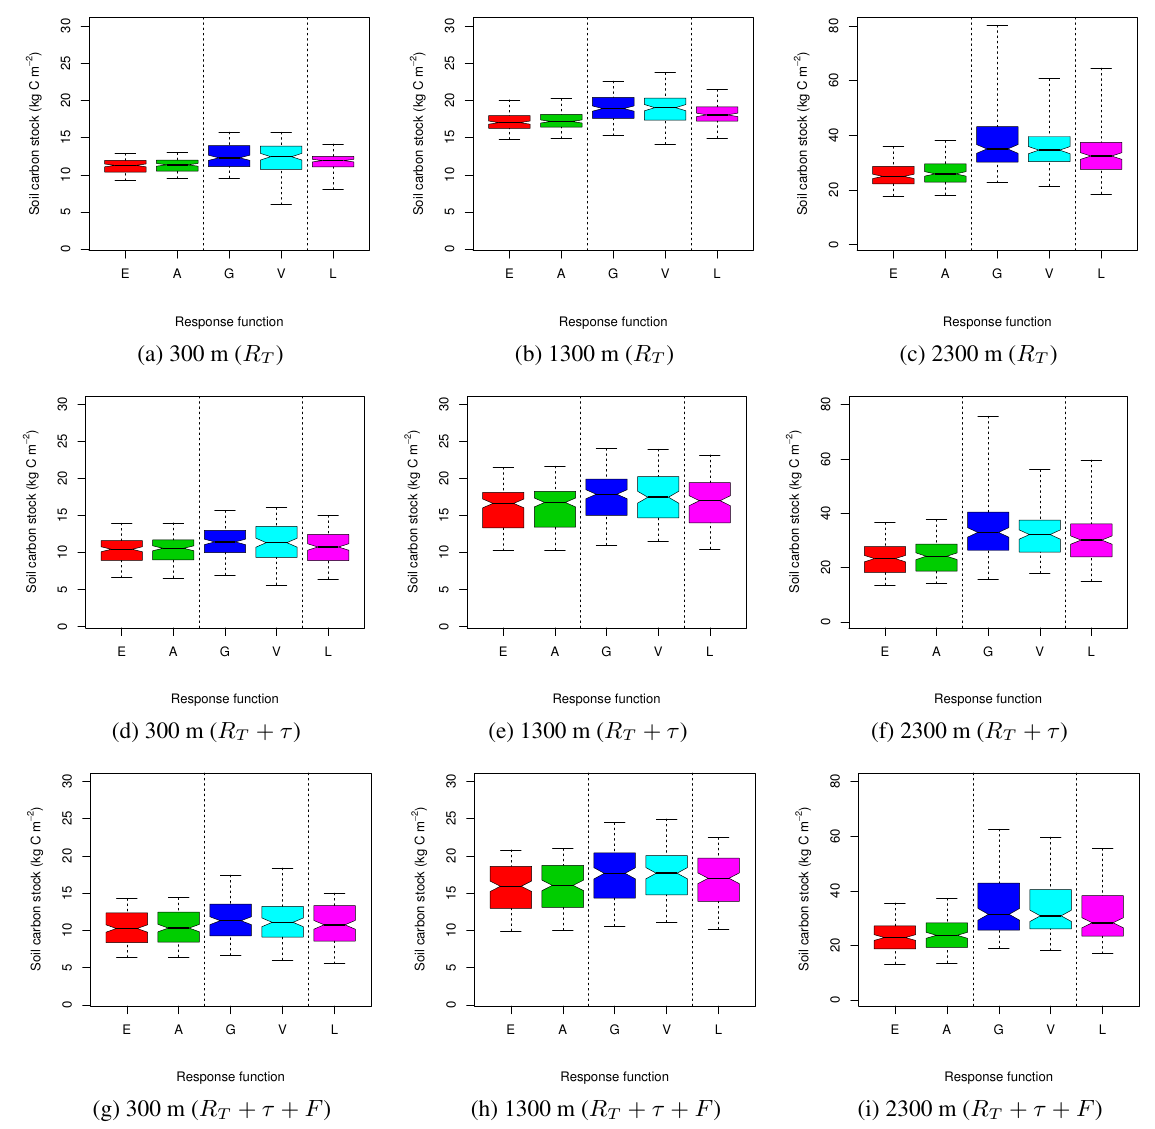
Fig. 4. Uncertainty in long-term soil carbon stocks with climate of August 2006 as an example output for the cases with (a–c) only varying Fig. 4: Uncertainty in long-term soil carbon stocks with climate of August 2006 as an example output for the cases with temperature response functions ( R T ), (d–f) additionally varying turnover times ( R T + τ ) and (g–i) litter fractionation ( R T + τ + F ). Pairs of (a-c) only varying temperature response functions ( R T ), (d-f) additionally varying turnover times ( R T + τ ) and (g-i) litter response formulations and sites have been grouped according to the temperature response used. The box plots show the median, the lower fractionation ( R T + τ + F ). Pairs of response formulations and sites have been grouped according to the temperature response and upper quartiles and span over the 95% confidence interval. Models are separated by the dashed lines into three distinct groups with Fig. 4: Uncertainty in long-term soil carbon stocks with climate of August 2006 as an example output for the cases with similar means and uncertainty ranges. Abbrevations as in Fig. 1. At 300m and 1300m (a, b, d, e, g, h) the same ordinate scale is used, used. The box plots show the median, the lower and upper quartiles and span over the 95% confidence interval. Models are (a-c) only varying temperature response functions ( R T ), (d-f) additionally varying turnover times ( R T + τ ) and (g-i) litter whereas at 2300m (c, f, i) a different scale is separated by the dashed lines into three distinct groups with similar means and uncertainty ranges. Abbrevations as in Fig. 1. fractionation ( R T + τ + F ). Pairs of response formulations and sites have been grouped according to the temperature response Fig. 4: Uncertainty in long-term soil carbon stocks with climate of August 2006 as an example output for the cases with At 300 m and 1300 m (a,b,d,e,g,h) the same ordinate scale is used, whereas at 2300 m (c,f,i) a different scale is used. used. The box plots show the median, the lower and upper quartiles and span over the 95% confidence interval. Models are (a-c) only varying temperature response functions ( R T ), (d-f) additionally varying turnover times ( R T + τ ) and (g-i) litter separated by the dashed lines into three distinct groups with similar means and uncertainty ranges. Abbrevations as in Fig. 1. fractionation ( R T + τ + F ). Pairs of response formulations and sites have been grouped according to the temperature response At 300 m and 1300 m (a,b,d,e,g,h) the same ordinate scale is used, whereas at 2300 m (c,f,i) a different scale is used. used. The box plots show the median, the lower and upper quartiles and span over the 95% confidence interval. Models are separated by the dashed lines into three distinct groups with similar means and uncertainty ranges. Abbrevations as in Fig. 1. At 300 m and 1300 m (a,b,d,e,g,h) the same ordinate scale is used, whereas at 2300 m (c,f,i) a different scale is used.